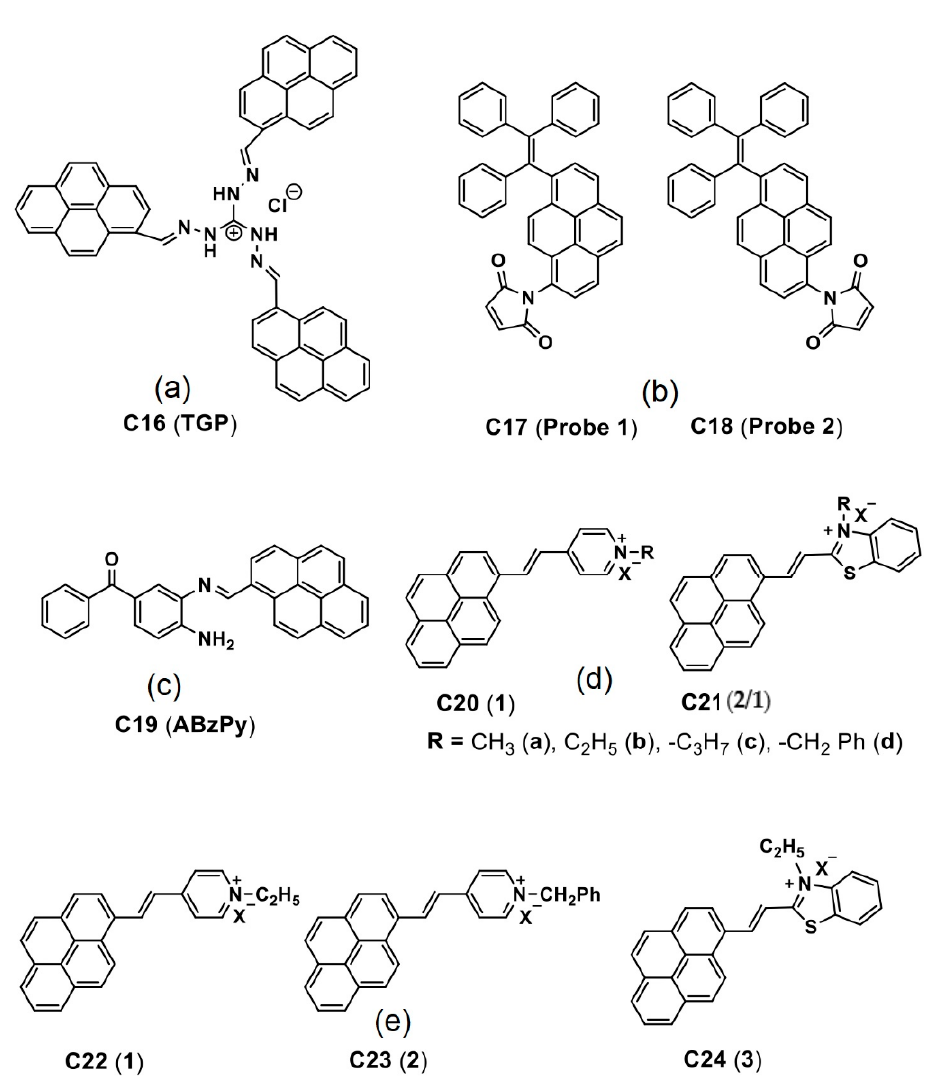
Figure 11. ( a – e ) C16 – C24 are the chemdraw structures of pyrene-based AIEgens, small molecules and dyes reported for in vitro / in vivo imaging (Note: the original representation or numbering of the molecules were provided in the brackets along with respective reference numbers).